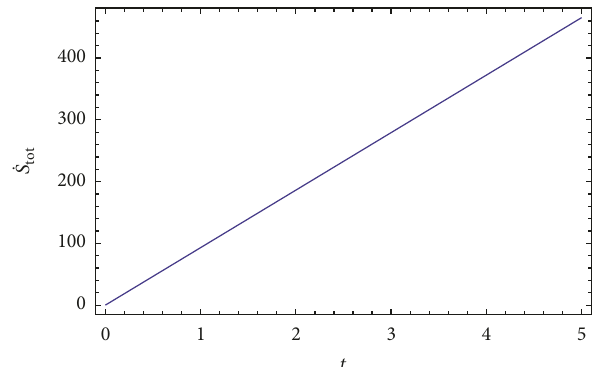
̇𝑆 Figure 1: Plot of tot by taking Bekenstein entropy as entropy at apparent horizon, where time is measured in seconds.